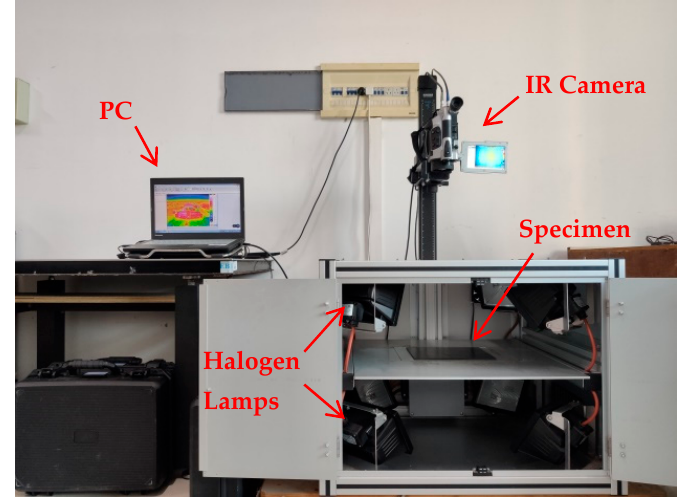
Figure 7. Synchronized infrared image acquisition system.